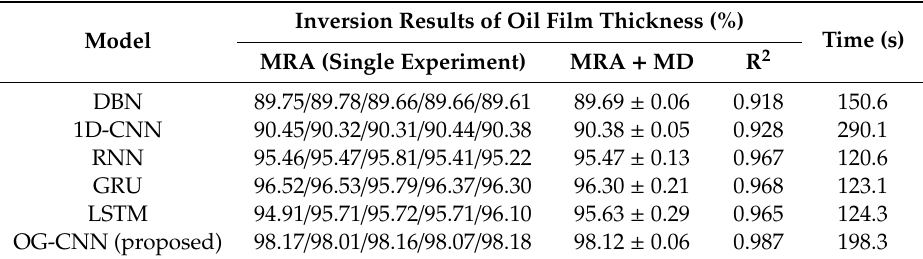
Table 9. Inversion results for various deep learning